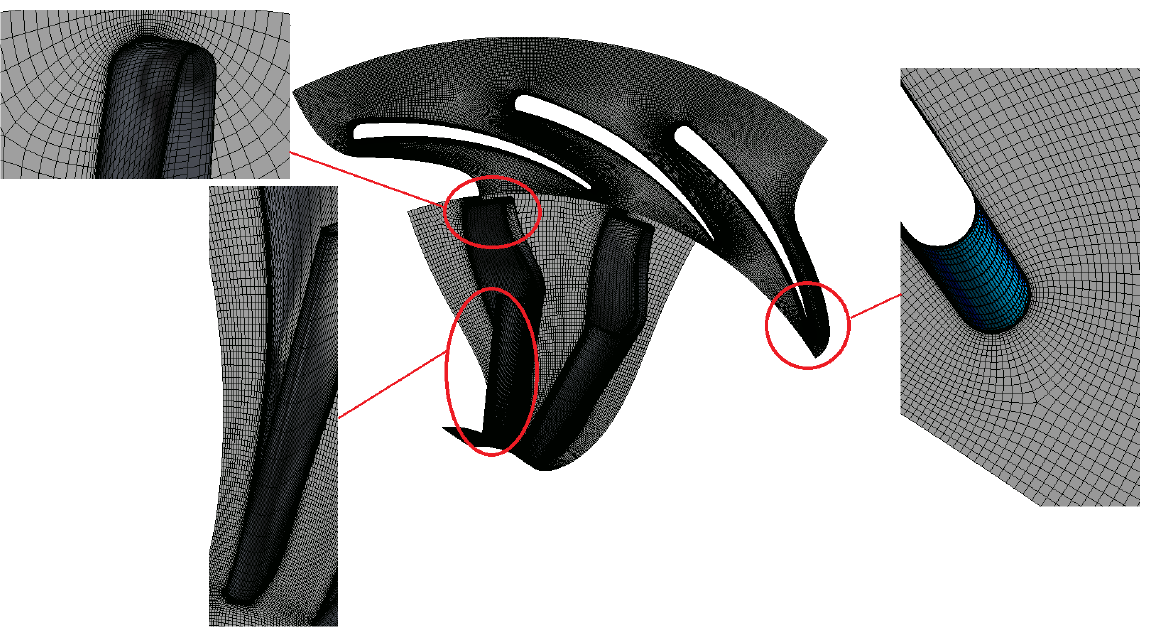
Figure 12. Mesh of the passage with 1.0 × 10 6 elements.